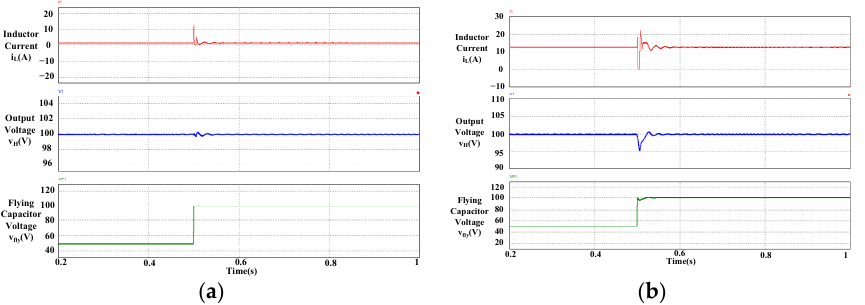
Figure 18. The waveforms of S 3 short-circuit fault (V L > 0.5 V H ). ( a ) Light load 100 W; ( b ) heavy load 1000 W.